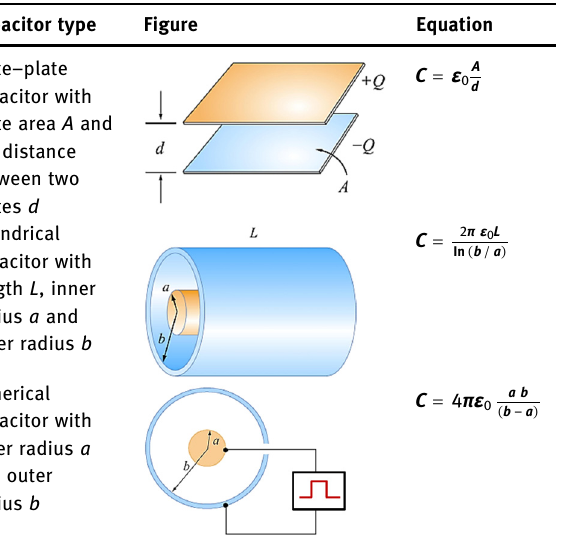
Table 1: Cavity shape, equation and value inside HV insulators